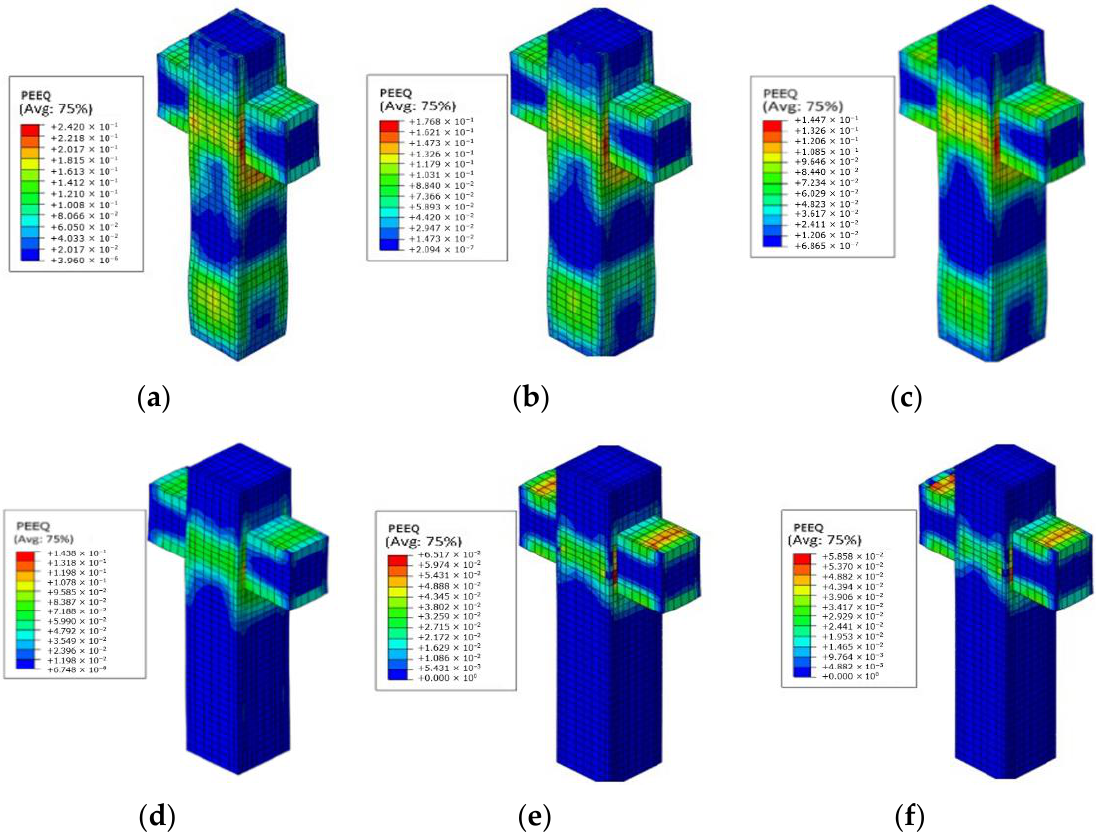
Figure 14. Contours of equivalent plastic strain under various values of λ : ( a ) λ =2.3; ( b ) λ =2.6; ( c ) λ =2.7; ( d ) λ =2.8; ( e ) λ =3.6; ( f ) λ =4.